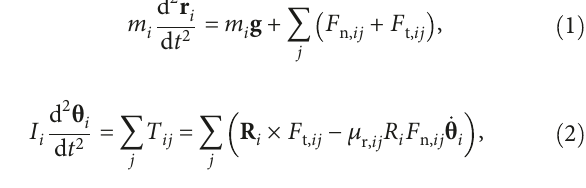
Figure 1: Force diagram of individual particles in DEM